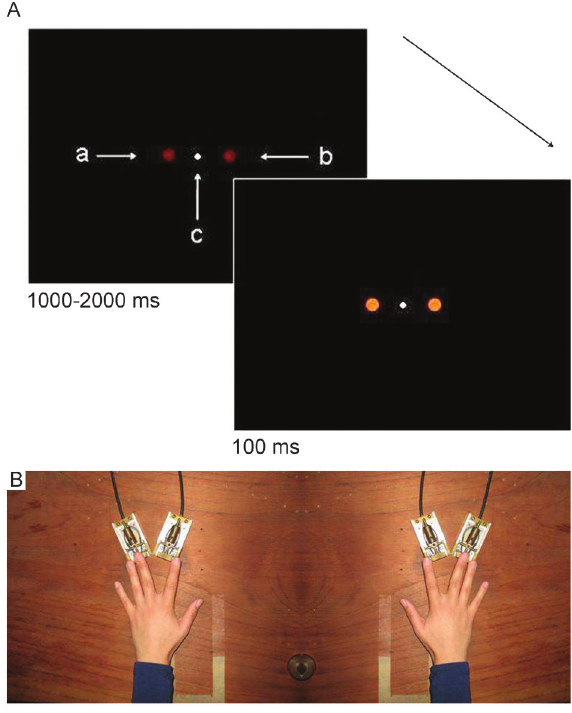
Figure 1. Panel A shows a schematic representation of the sequence of events in a trial. The target stimulus, represented by a left, right or left-right light red filled circle, appeared 1000 to 2000 ms after the beginning of the trial and lasted for 100 ms. ‘‘a’’ indicates the left dark red filled circle. ‘‘b’’ indicates the right dark red filled circle. ‘‘c’’ indicates the central white fixation point. Panel B shows a picture of the responding keys on the left and right sides. Note the initial position of the left and right middle fingers pressing, respectively, the left and right outer keys.